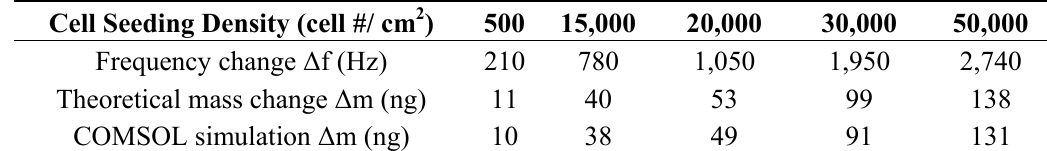
Table 2 . The mass change magnitude corresponding to different frequency shifts by using Sauerbrey equation (5) and COMSOL